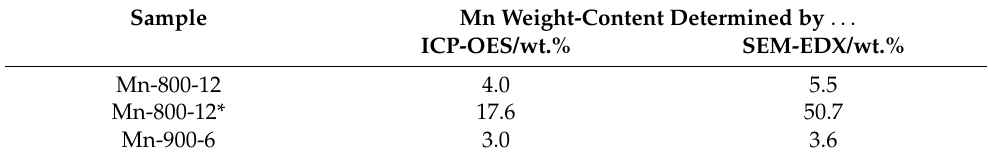
Table 1. Mn weight-contents of selected samples as determined by ICP-OES and SEM-EDX. Sample Mn Weight-Content Determined by . . . ICP-OES/wt.%